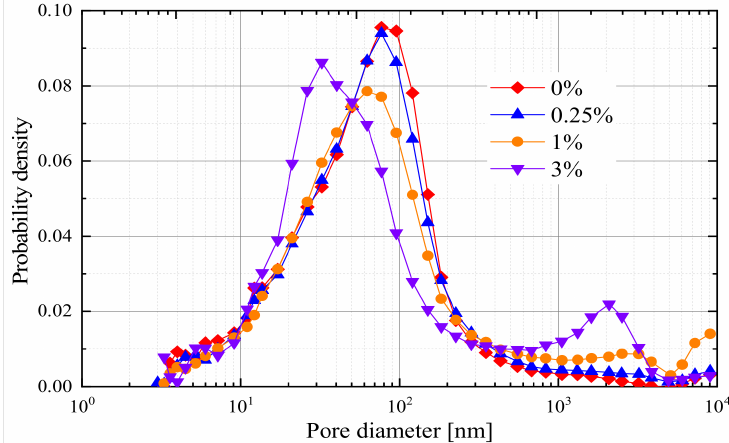
Figure 3. Pore radius density curves of NS-modified silty clay samples.